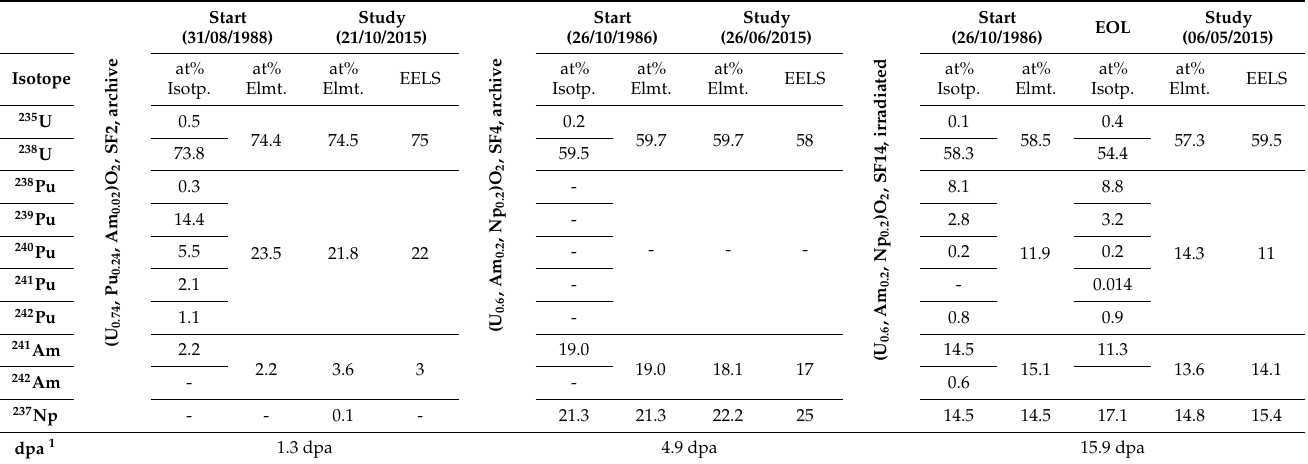
1 The dpa values were calculated by the theoretical isotopic composition of the sample and may be subject to errors due to their local distribution, in particular for the scale of the TEM samples. For a better reading, particularly for time correspondence with spent fuel, the calculated values were kept without introducing errors. In particular, the sample with the largest possible error (SF14) corresponded to a standard burnup of spent fuel of more than 1 million years. It was rather more important to highlight the time scale than precise